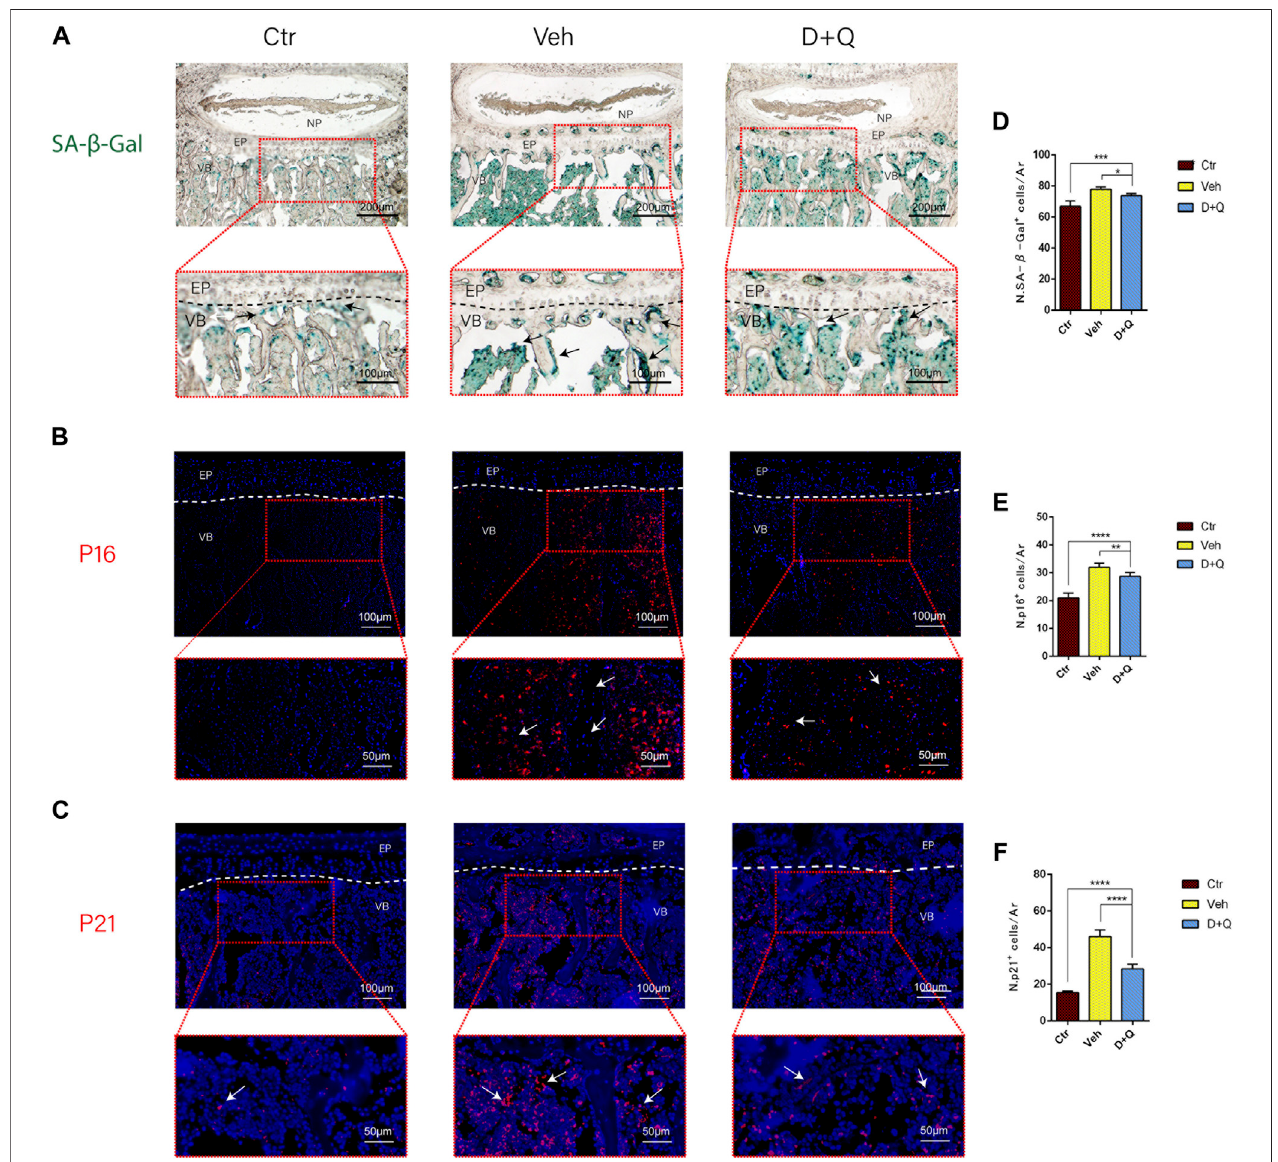
FIGURE 4 | Qualitative and quantitative detection of senescent cells in the sub-endplate region. The expression of (A) SA- β -gal, (B) P16, and (C) P21 could be observed in the intervertebral disc (IVD) by histological assessment. Cell nuclei (B, C) were stained with DAPI (blue). (D-F) Quantitation of the number of SA- β -gal, P16, and P21 positive cells in the sub-endplate region. Data are represented as mean ± SD. NP, nucleus pulposus; AF, annulus fi brosus; EP, endplate; Ctr, control group; Veh, vehicle group; D + Q, dasatinib and quercetin group. Scale bar = 100 μ m (upper), 50 μ m (lower). D + Q vs. Ctr group and Veh group; ns, no signi fi cance; * p